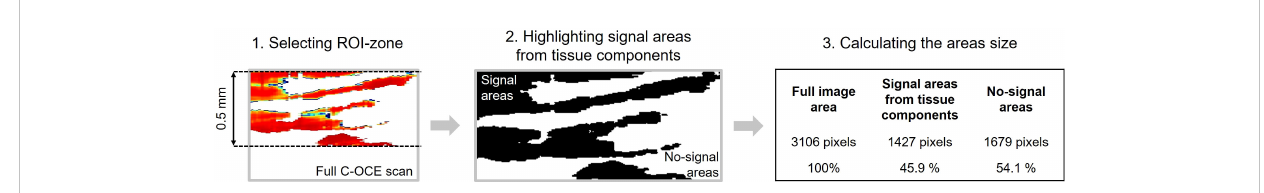
FIGURE 3 Isolation and quanti fi cation of non-signal regions in C-OCE images for differentiating MAC and CRAC with cribriform pattern.